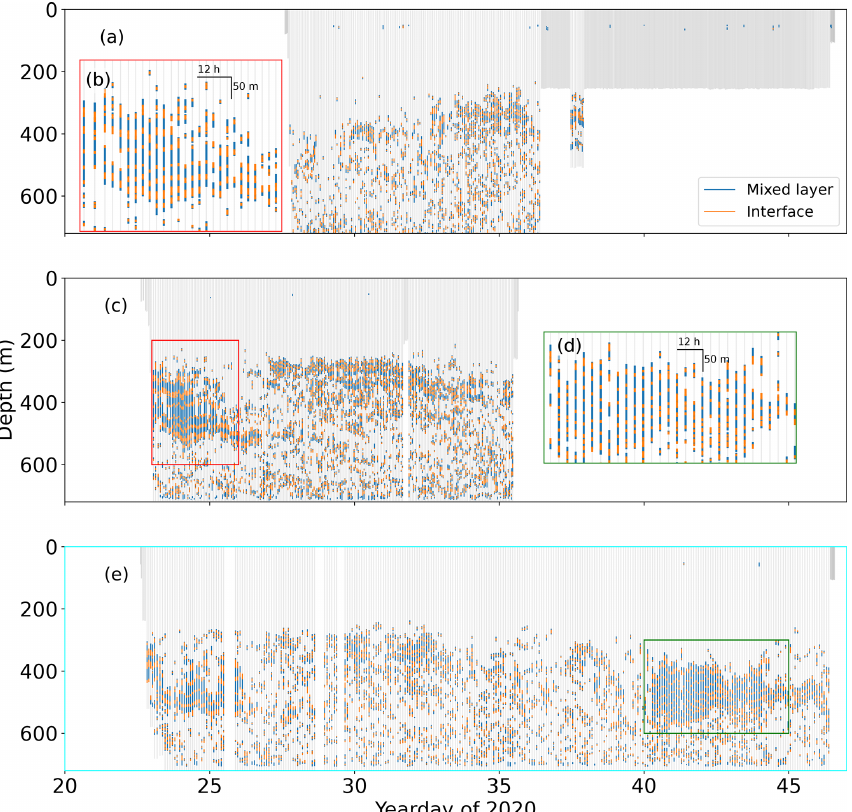
Figure 3. All thermohaline staircases detected in glider profiles. (a, c, e) Data from gliders SG579, SG620 and SG637 respectively. Data from gliders in the tropical North Atlantic. Panels (b) and (d) show expanded sections from boxes in (c) and (e) in the corresponding colour. Data from (e) are the basis for remaining figures in this paper, except where otherwise